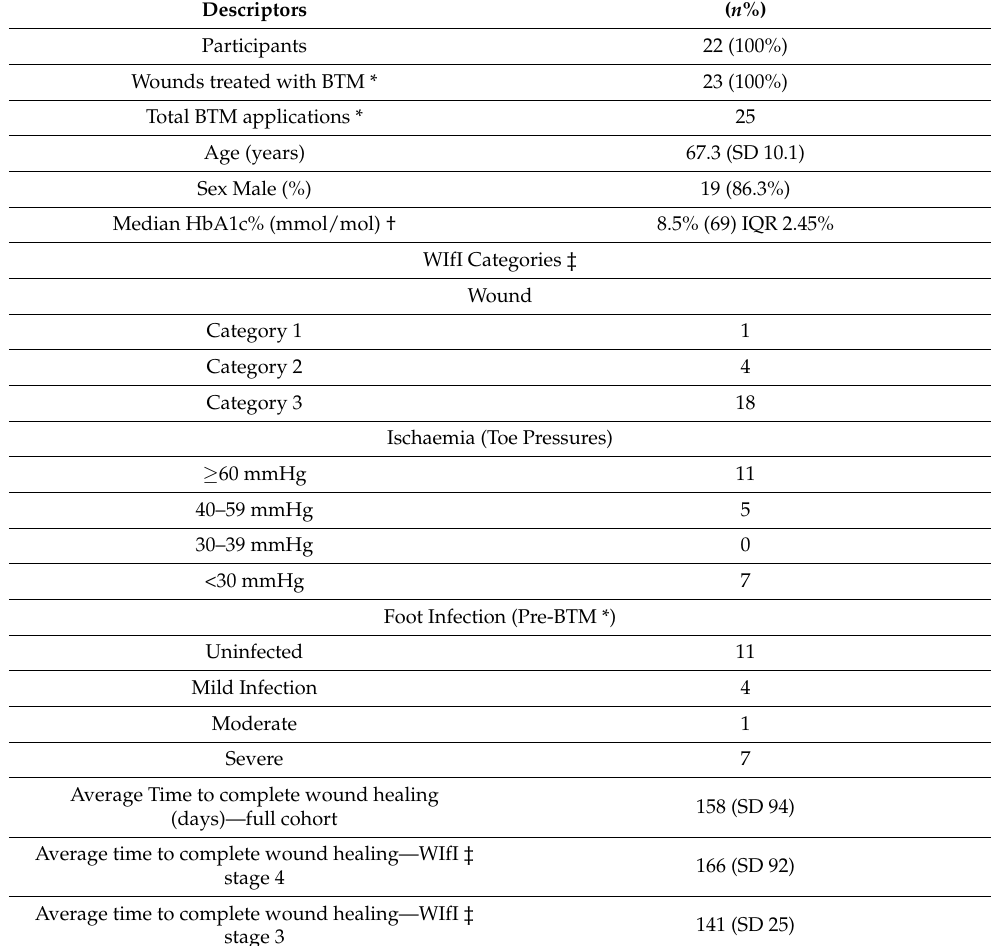
Table 1. Demographics and case